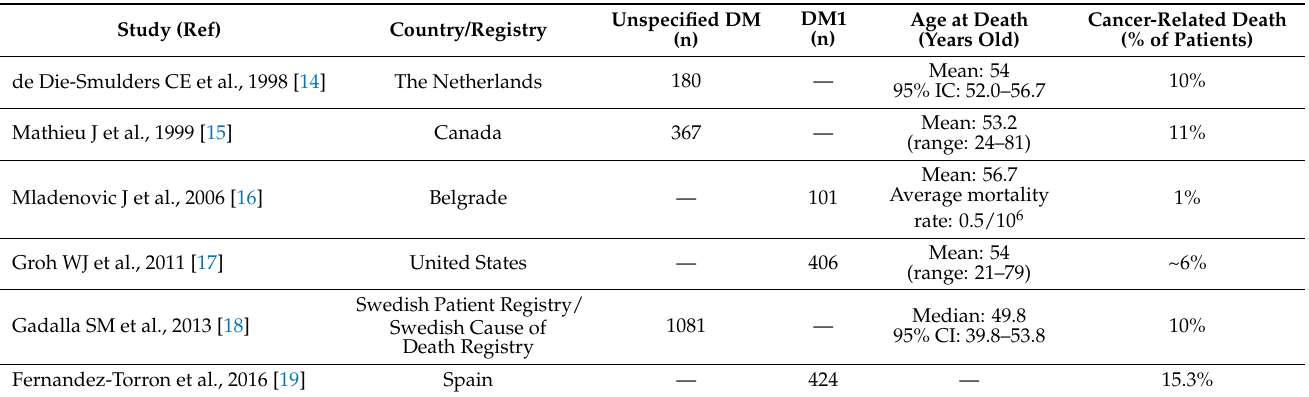
Table 1. Cancer-related death in